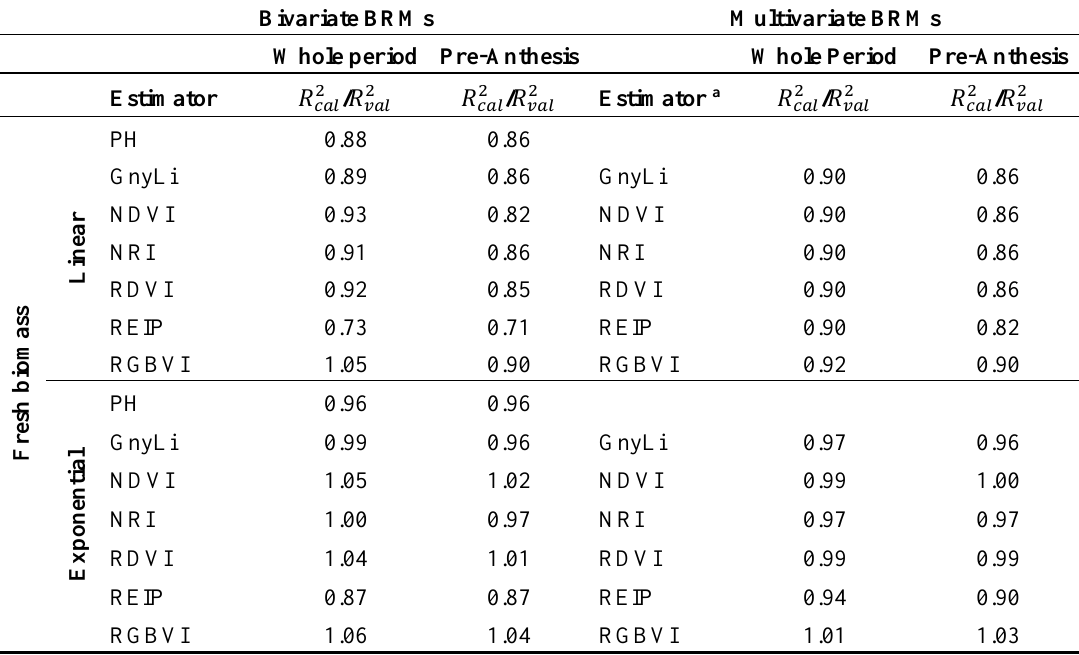
Bivariate BRMs Multivariate